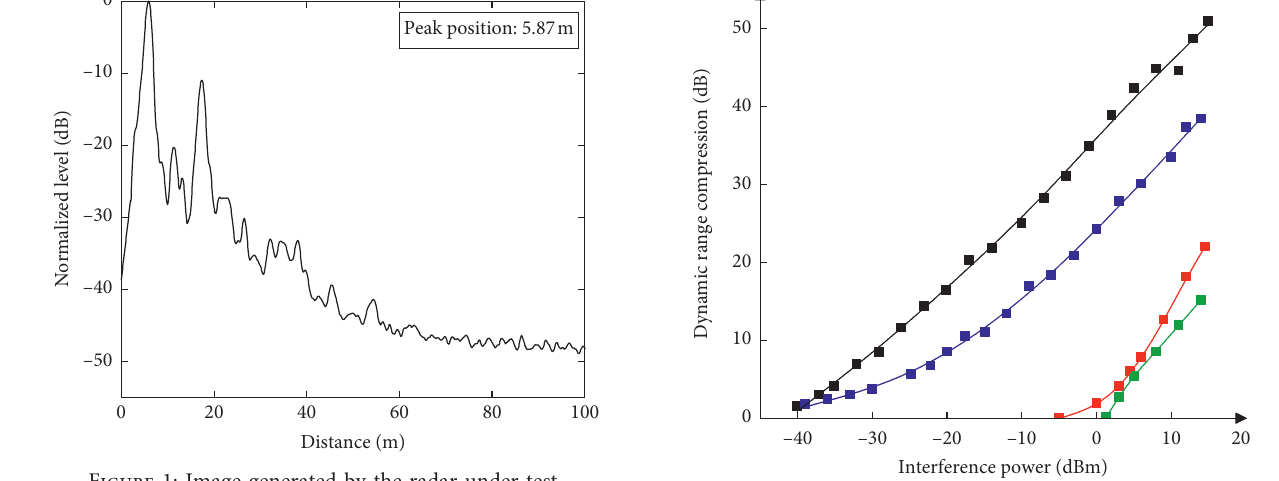
Figure 1: Image generated by the radar under test.